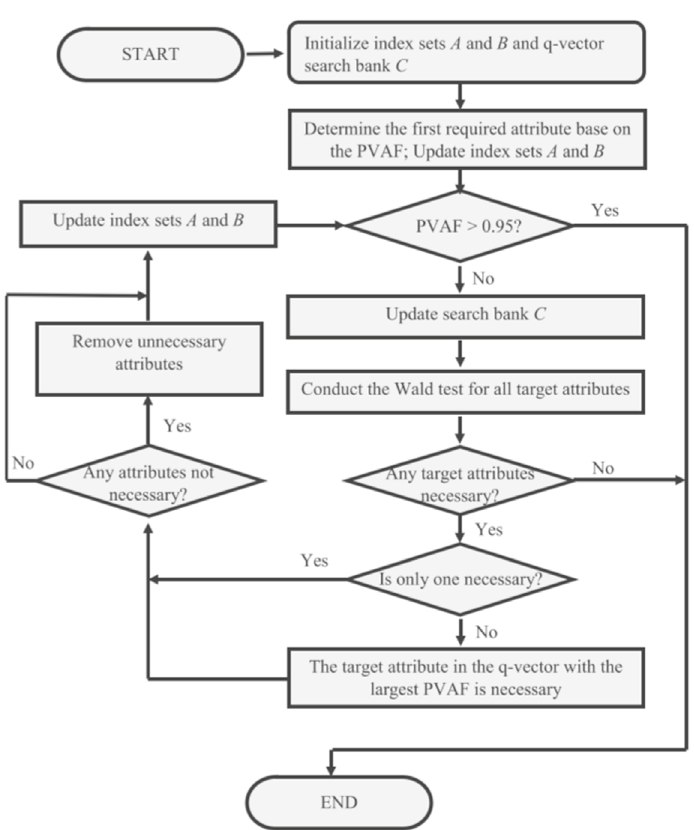
Fig. 3 Flowchart of the Stepwise Method. This flowchart was reprinted from Ma and Torre